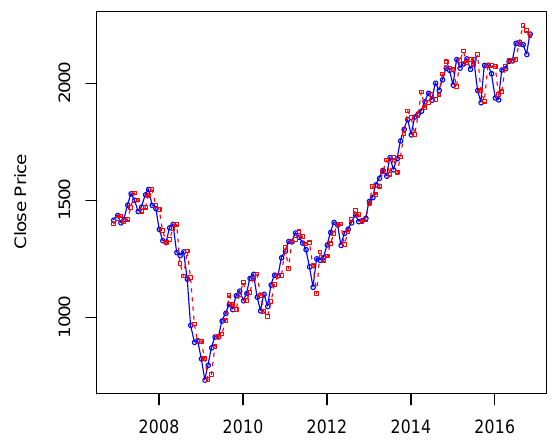
Figure 3. Predicted S&P 500 monthly prices from November 2006 to November 2016 using four-state